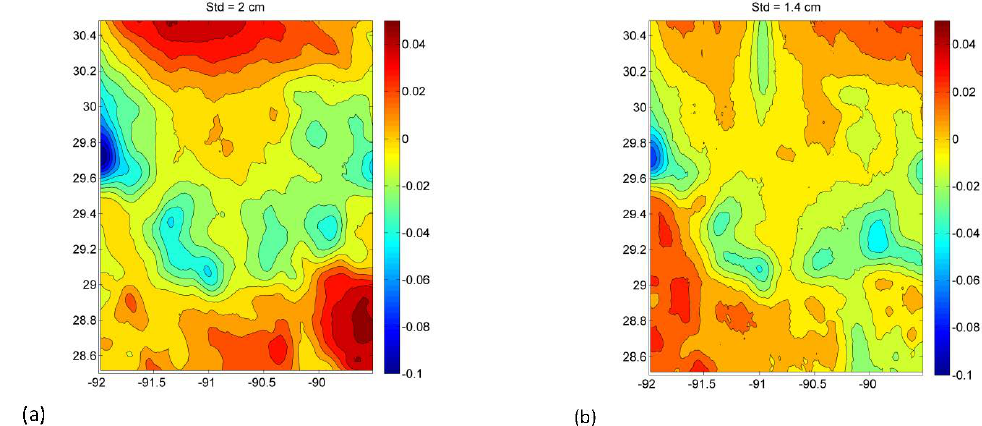
Figure 6: GMS (a) and QGMS (b) differences from the USGG12 geoid for the Louisiana test area in 1 cm contours.